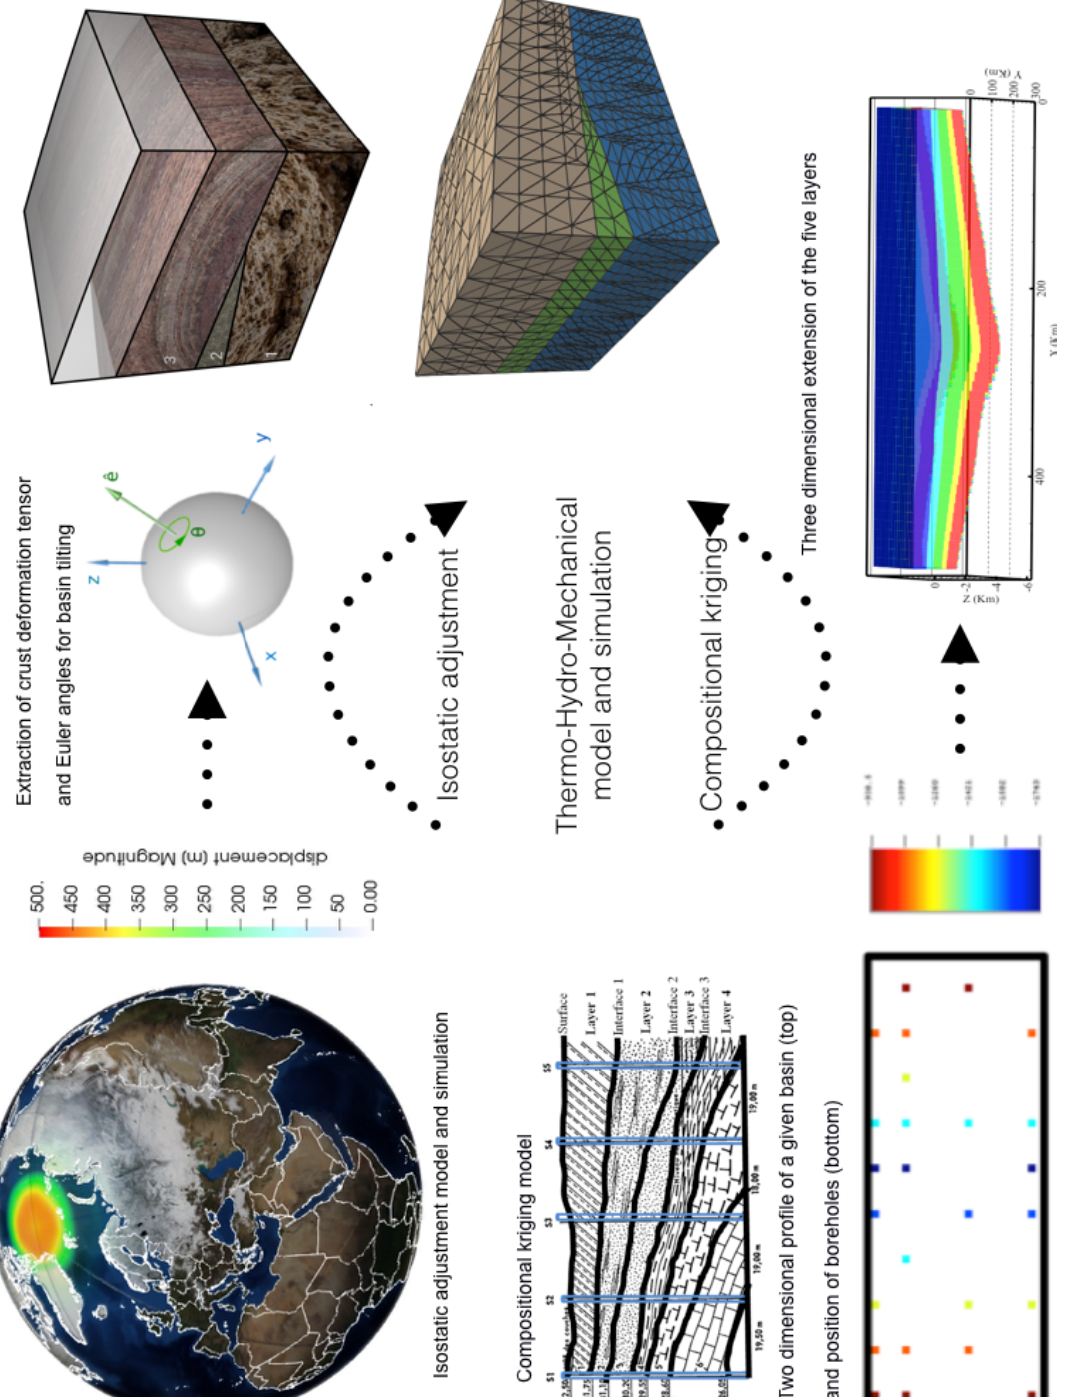
Figure 1. A visual sketch of the multiscale model